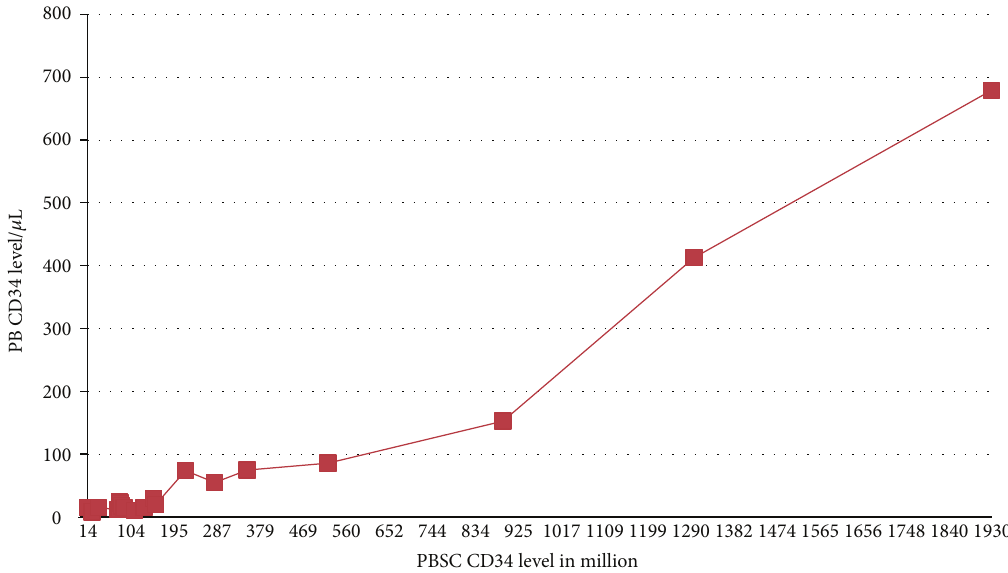
Figure 1: Graphical representation of the peripheral blood CD34 + level isolated from peripheral blood versus the final CD34 + level enumerated after processing.